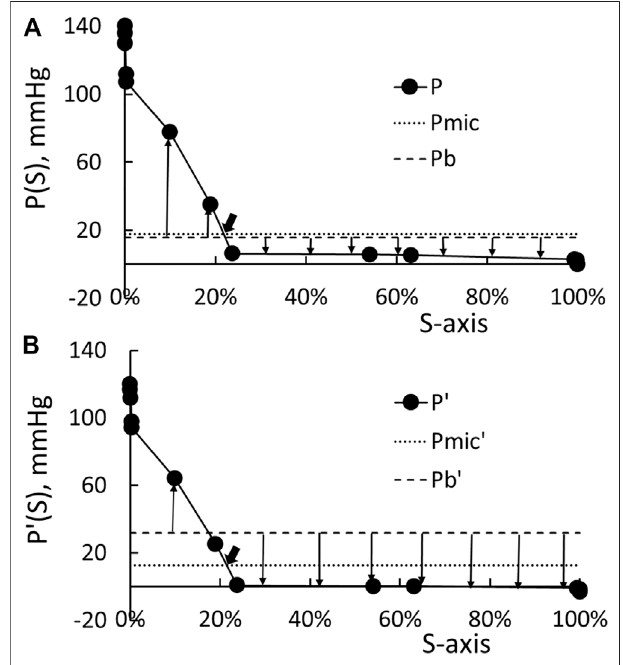
FIGURE 2 | (A) Distribution of the pre-HD blood pressure P. Pmic is the surfaceweightedaverageofthepressureinthemicrocirculation,andPbisthe base pressure ( Eq. 7 ). The up arrows indicate fl uid fi ltration to the tissue, and the down arrow indicates fl uid absorption by the circulation. (B) Distribution of post-HD blood pressure and the correspondent Pmic ’ and